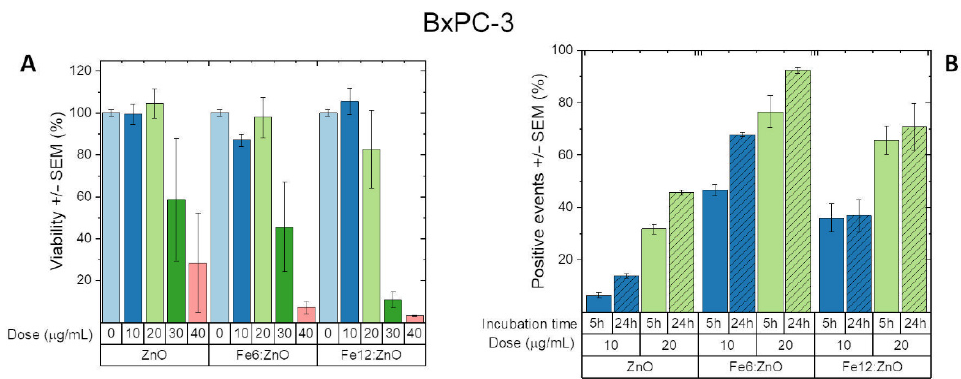
Figure 12. ( A ) BxPC-3 cell viability evaluated through the WST-1 assay at 24 h from ZnO and Fe:ZnO NPs administration. ( B ) BxPC-3 cell Fe:ZnO NP uptake evaluated through cytofluorimetry at 5 and 24 h from NP administration to cells. Error bars express standard error mean.